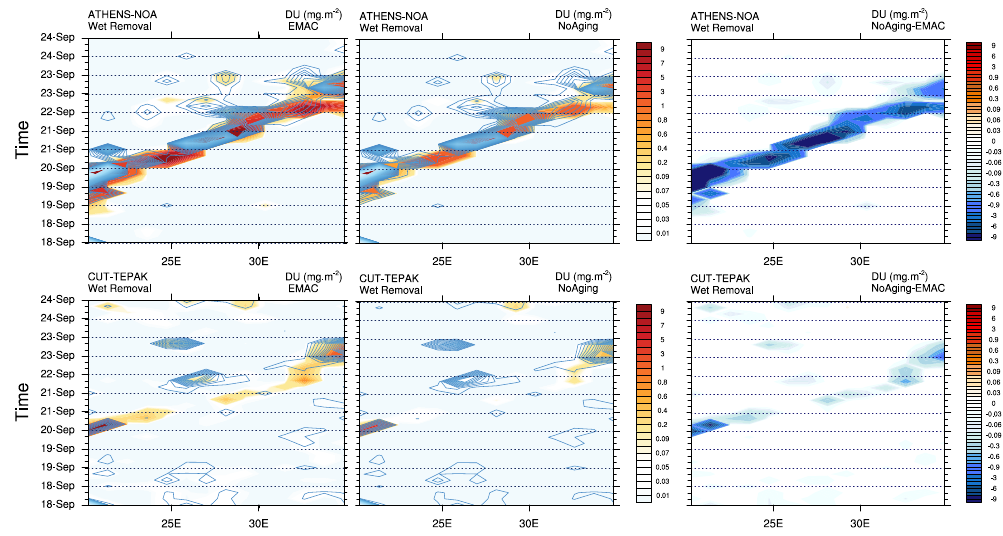
Figure 13. Time evolution of wet dust removal at the CUT-TEPAK and ATHENS-NOA stations for two simulations considering aged dust (EMAC) and non-aged, pristine dust particles (NoAging); (blue) TRIMM observations, (orange) EMAC precipitation (see text).